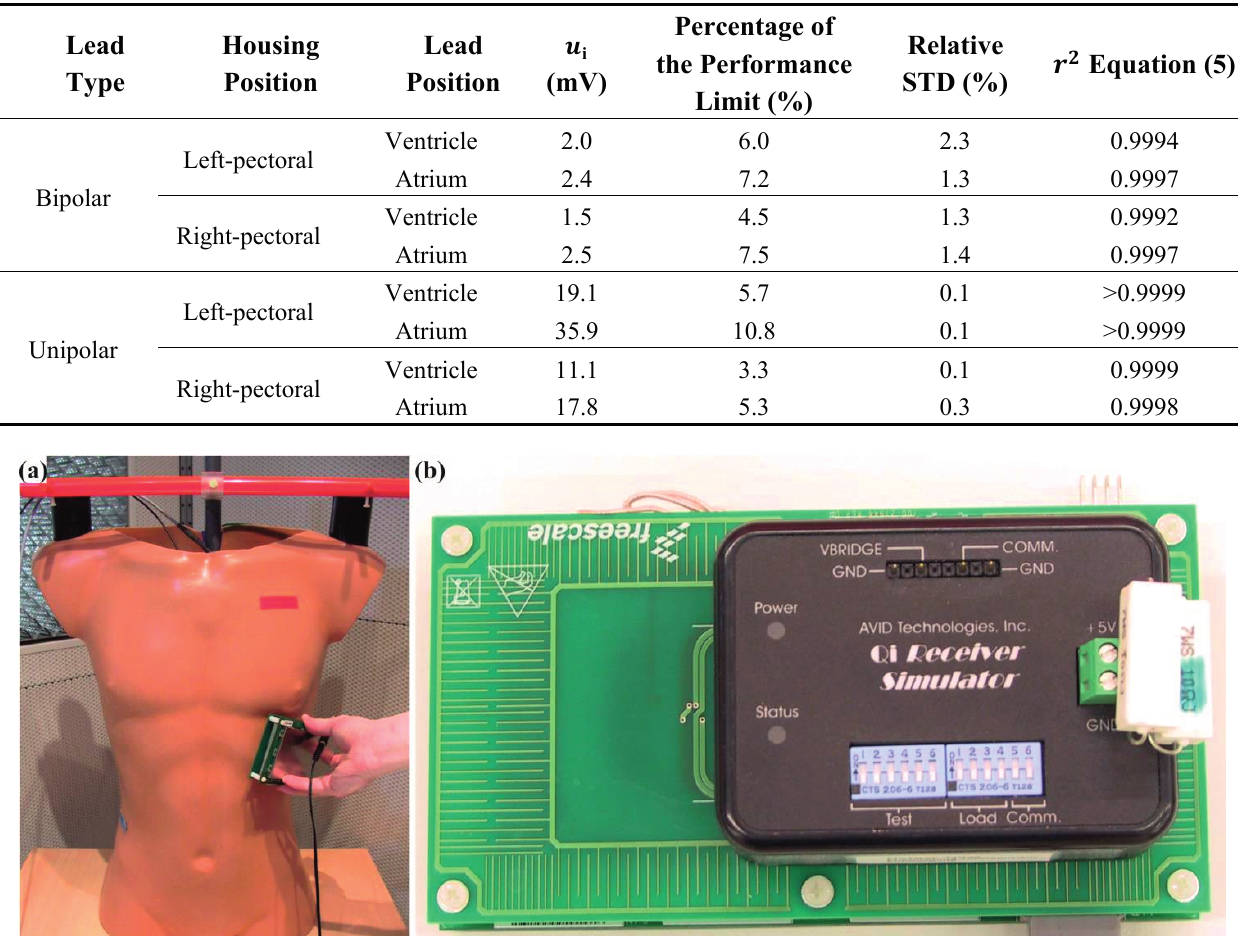
Table 2. The worst-case voltage induced by the exposure with the Qi-A13-Board in power transfer mode.